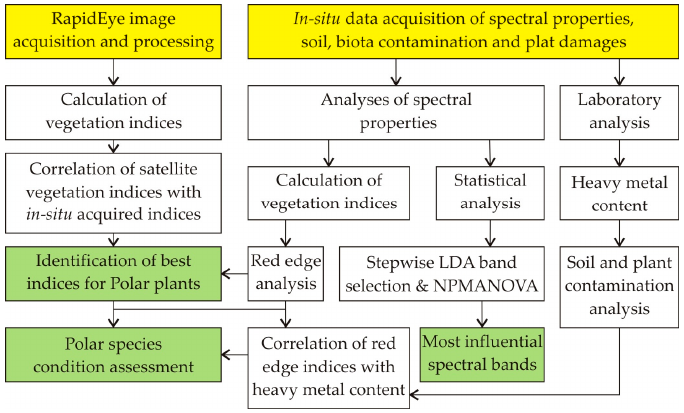
Figure 2. An overview of the pre-processing steps for statistical